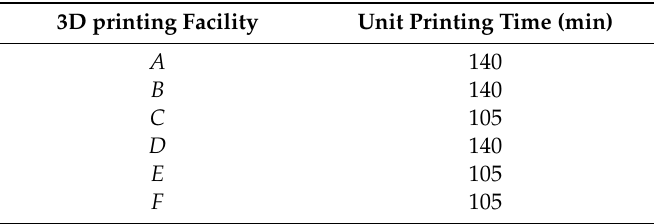
Table 9. Time required to print one piece in each 3D printing